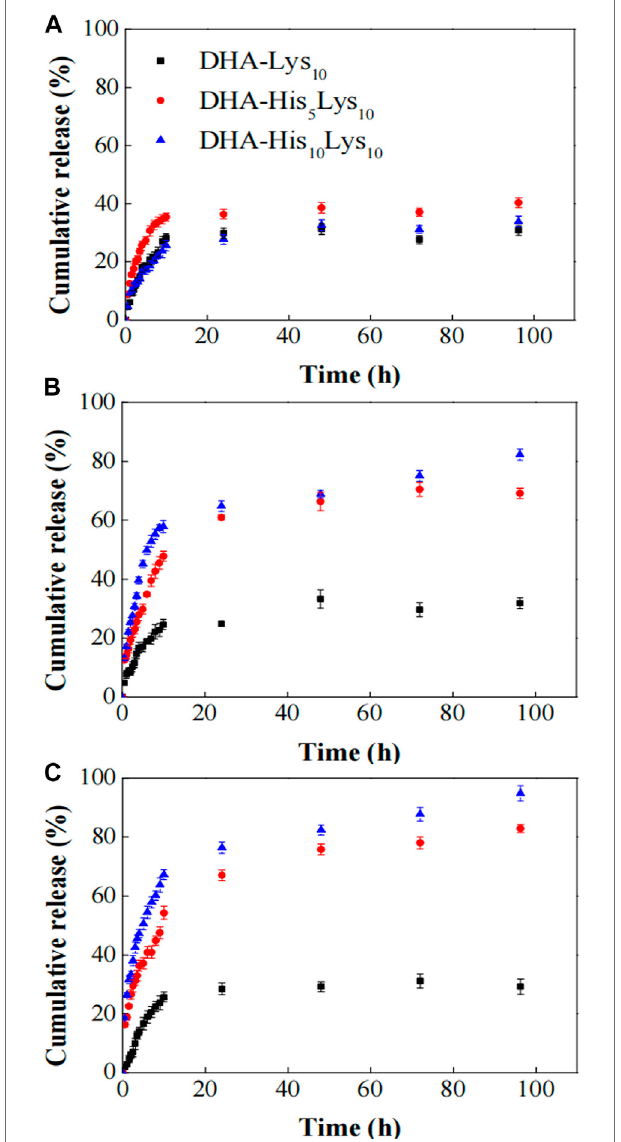
FIGURE 10 | In vitro DOX release from DHA-His x Lys 10 (x (cid:1) 0, 5, 10) micelles at pH 7.4 (A) , 6.0 (B) , and 5.0 (C) PBS solutions (Wang Y. et al., 2015). Abbreviation: DOX, doxorubicin; DHA, docosahexaenoic acid; His, histidine; Lys, lysine.